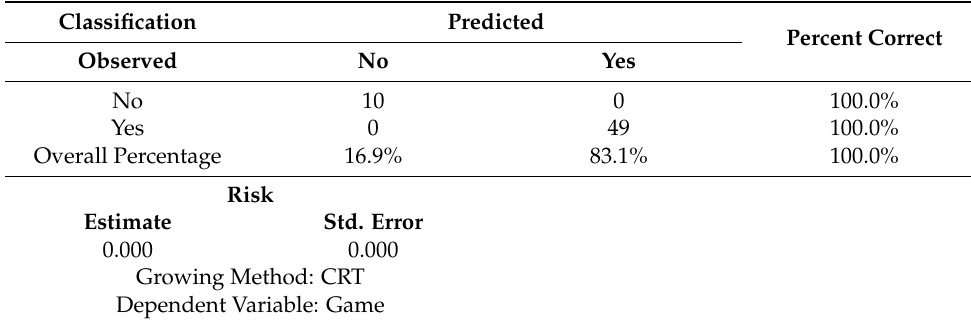
Table 7. CART—Classification and